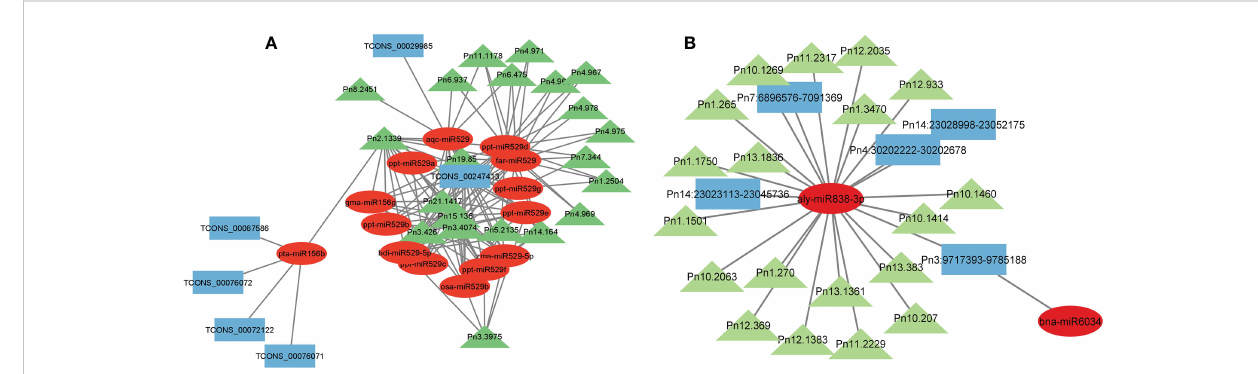
FIGURE 8 Representative fi gure showing the (A) lncRNA – miRNA – mRNA network (B) circRNA – miRNA – mRNA network.